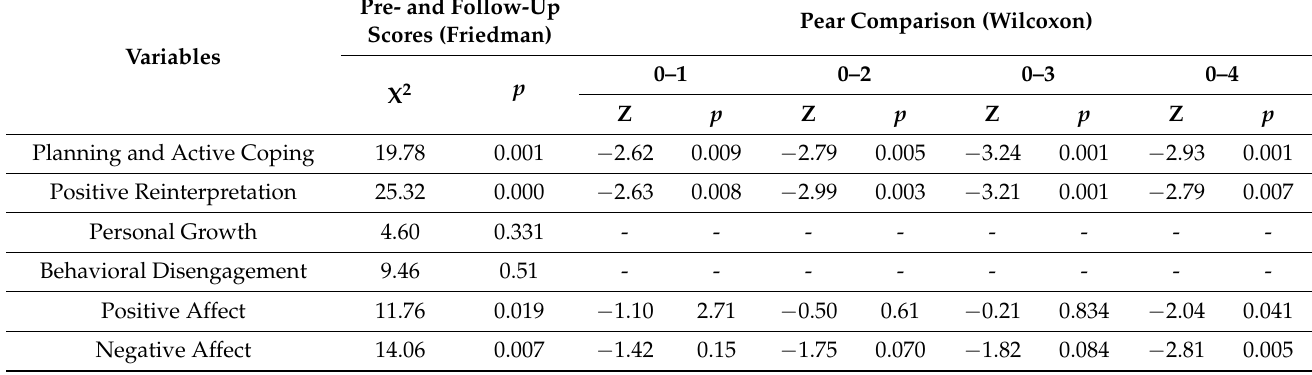
Table 4. Statistical tests (Friedman and Wilcoxon) for follow-up points and first point pre-intervention for COPE and PANAS